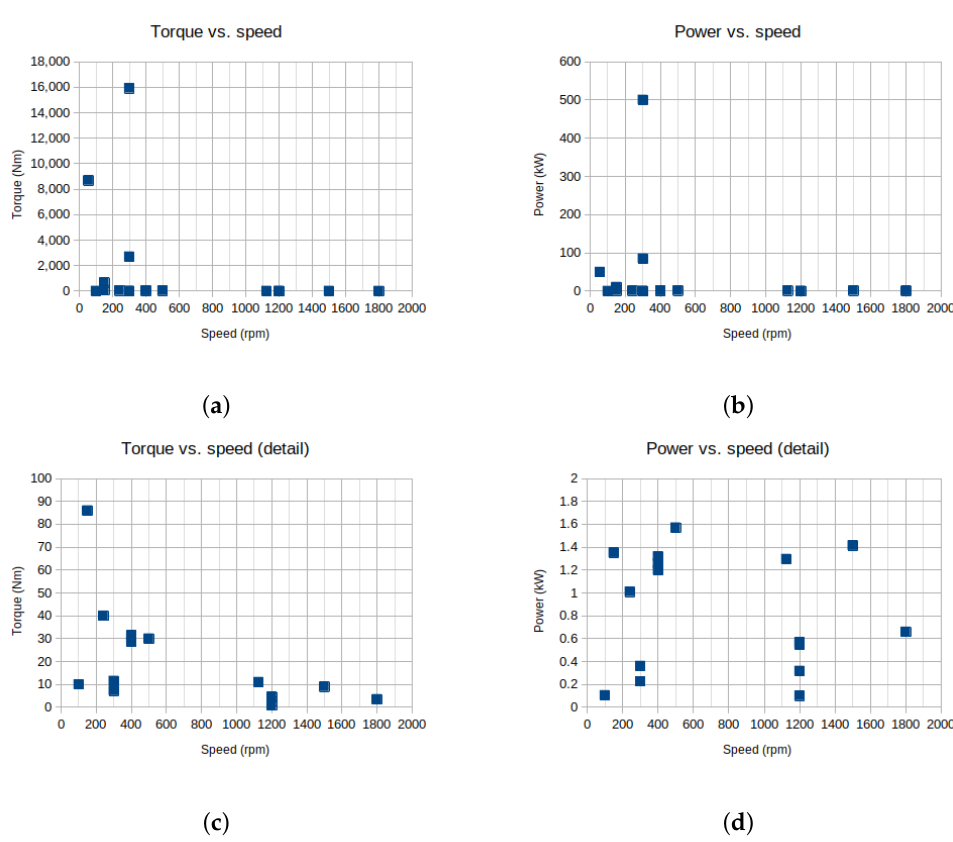
Figure 11. ( a ) Torque-speed map, ( b ) power-speed map, ( c ) detail of the torque-speed map, and ( d ) detail of the power-speed map of the TFMs found in